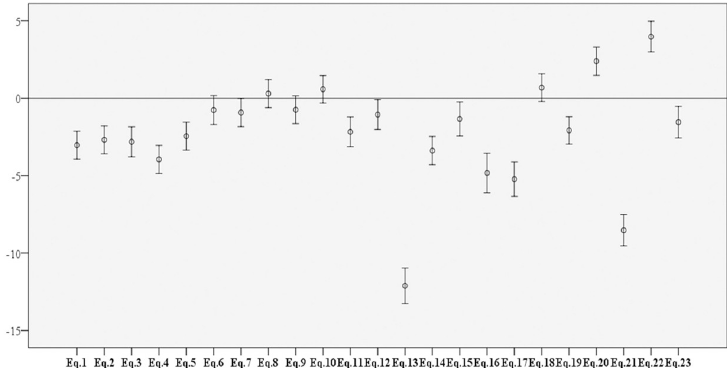
Fig 1. Bar chart of 95% confidence intervals of the mean difference between observed height and height estimated for elderly living in nursing homes (n = 168), Brazil,